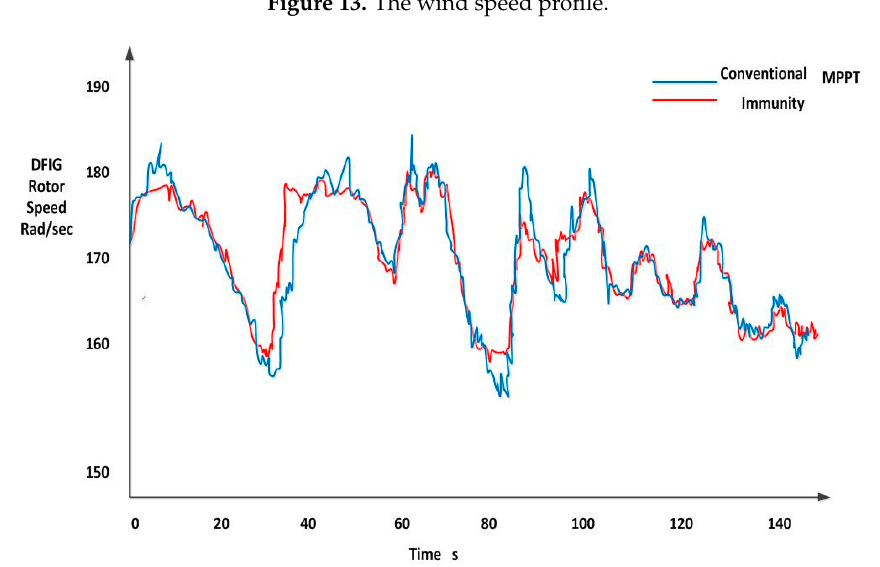
Figure 13. The wind speed profile. Energies 2018 , 11 , x